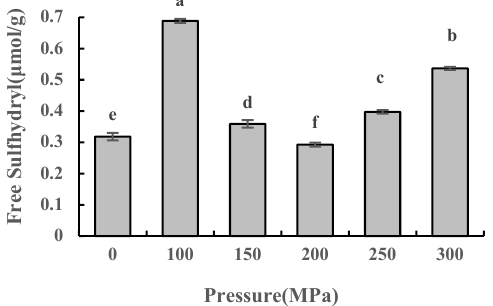
Figure 2. Free sulfhydryl content of casein under different pressure conditions. Different superscript letters within a column indicate significant differences between means ( p < 0.05).